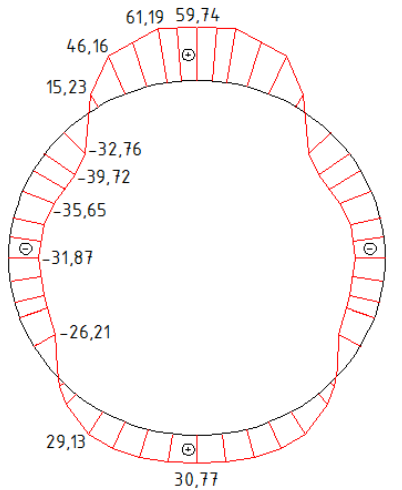
Figure 13. Stress diagram for fibre reinforced sand backfill ( σ max = 61 . 19